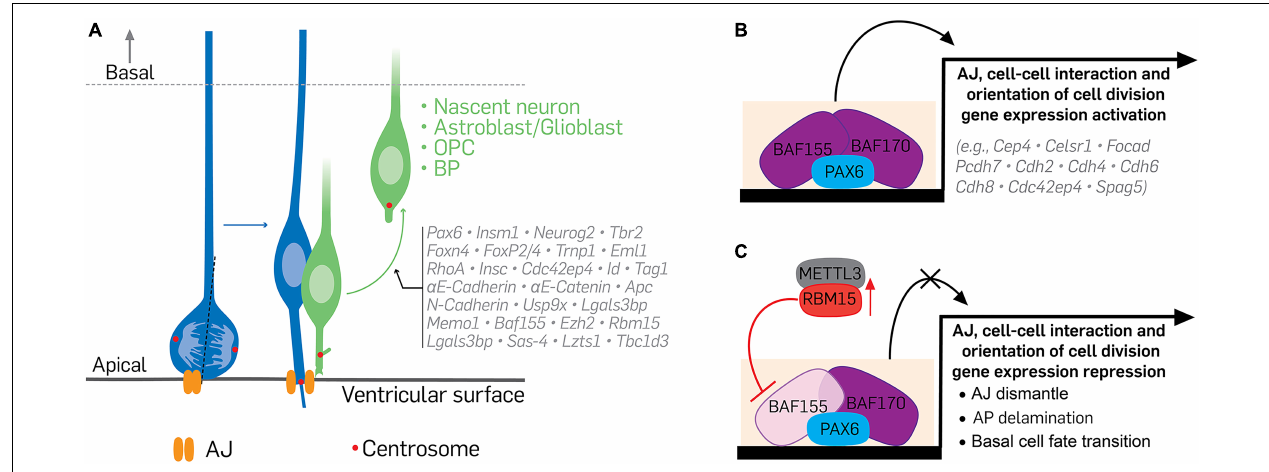
FIGURE 3 | Illustration of the transcriptional and epigenetic regulation of delamination. (A) The delamination of differentiating cells from apical to basal aspect of the cortical wall is under the control of specific transcriptional and epigenetic programs during cortical development. Neural cells at the verge of differentiating activate or suppress certain molecular factors, which lead to their withdrawal from apical adhesion and subsequent exit from the germinal neurepithelium. (B,C) Indicate a typical epigenetic program capable of altering the transcriptome of apical progenitors or their progenies to affect how they delaminate during cortical development. Under normal condition (B) , recruitment of the BAF complex, via binding of its scaffolding subunits BAF155 and BAF170, to Pax6-bound regulatory elements promotes the expression of genes necessary for apical cell adhesion, proper orientation of mitotic spindle, and maintenance of the apicobasal polarity of cortical apical progenitors. Together, these preserve the proliferative nature of cortical neurepithelium. (C) However, to activate cell differentiation in the neurepithelium, BAF155 expression is downregulated or inhibited in neuroepithelial cells. A notable mechanism of BAF155 downregulation is inhibition of its expression by METTL3-mediated activity of RBM15 or by RBM15 upregulation. Lack of BAF155 alters PAX6-mediated BAF complex recruitment/engagement leading to downregulation of the genes involved in cell adhesion, cell division, and cell polarity maintenance. These culminate in cell differentiation, loss of adherens junctions, and increased delamination of apical progenitors or their derivatives. Vertical red arrow pointing upward denote upregulation or overexpressing of RBM15. AJ, adherens junction; AP, apical progenitor; BAF, Brg1/Brm associated factor; METTL3, methyltransferase like 3; RBM15, RNA binding motif protein